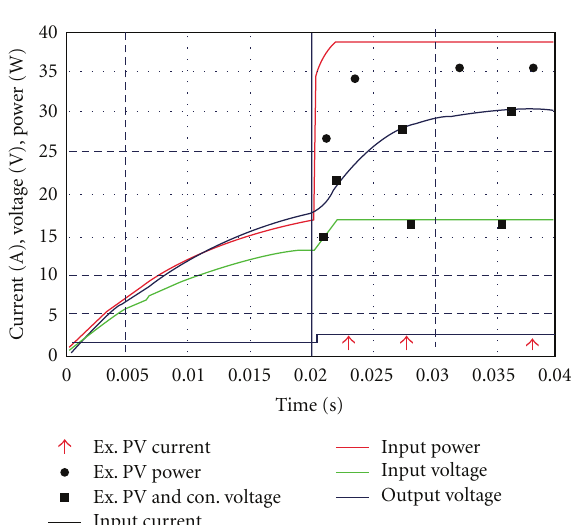
Figure 25: Variation of current, power for variable irradiation with experimental